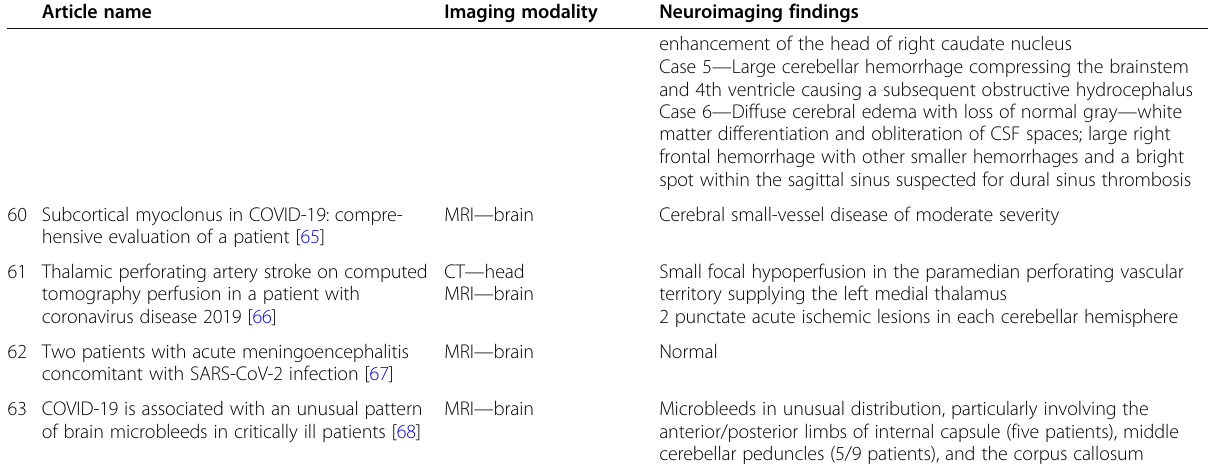
Table 1 Reported studies on COVID-19 patients with neurological manifestations with positive findings on major imaging